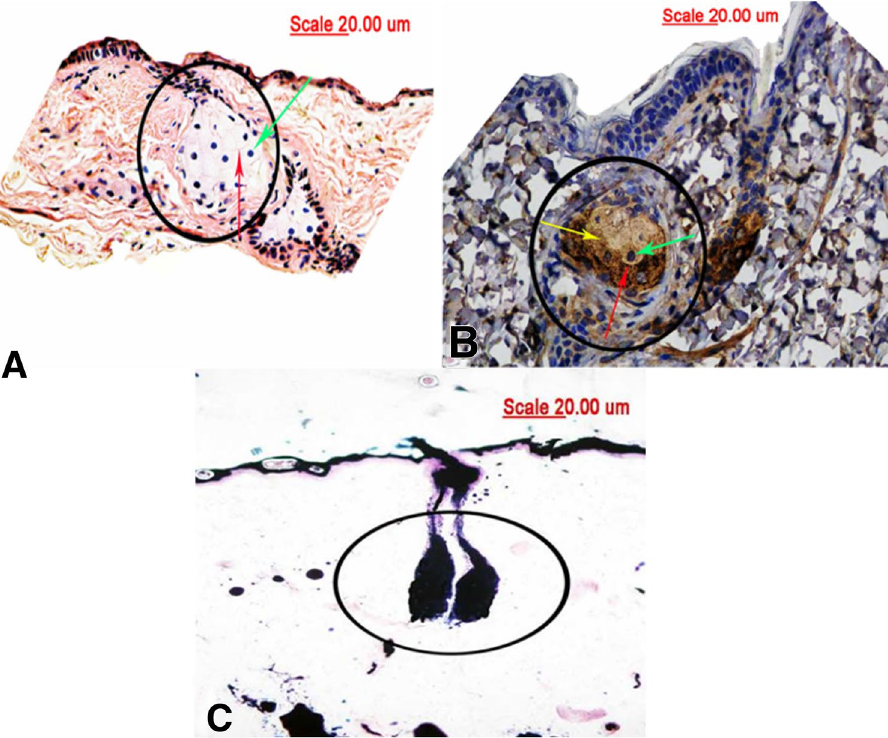
Figure 4. Photomicrographs (×400) of paraffinized tissue sections of control mice allowing, in ( A ), the cellular limits identification (red arrow) and the presence of nuclei (green arrow) by HE staining. In ( B ), notice the good expression of intracytoplasmic lipids in sebaceous cells (yellow arrow), allowing the identification of cellular limits (red arrow) and the presence of nuclei (green arrow) by ADPH immunohistochemistry. ( C ) Shows frozen tissue sections of the control group mice stained with Sudan Black. Notice the presence of tissue fat spots and lipid expression in sebaceous glands (black